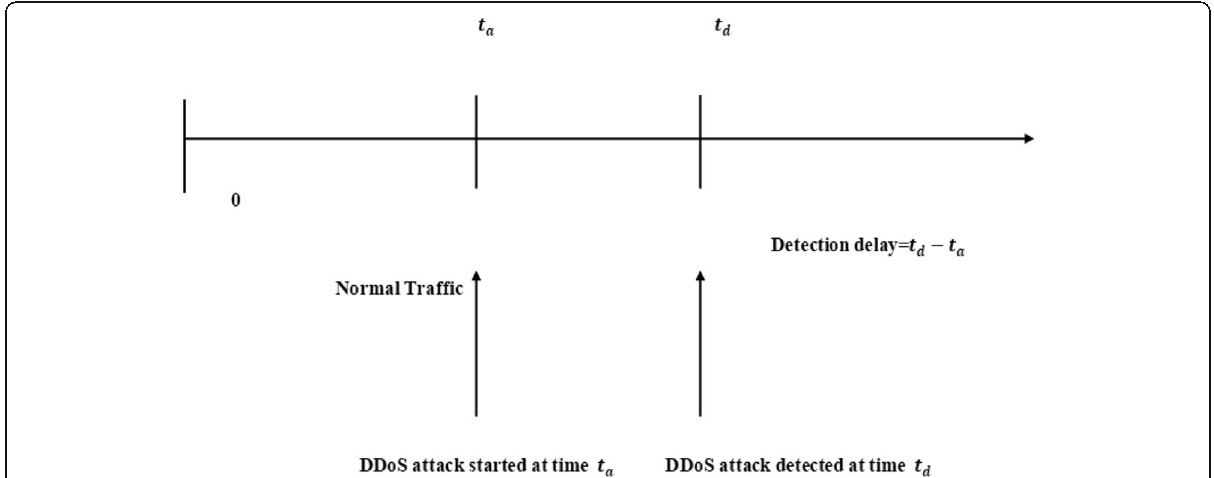
Fig. 3 Timeline showing attack start time, attack detected time, and the delay. It shows network state. At the time t a , DDoS is started and at the time t d , the attack is